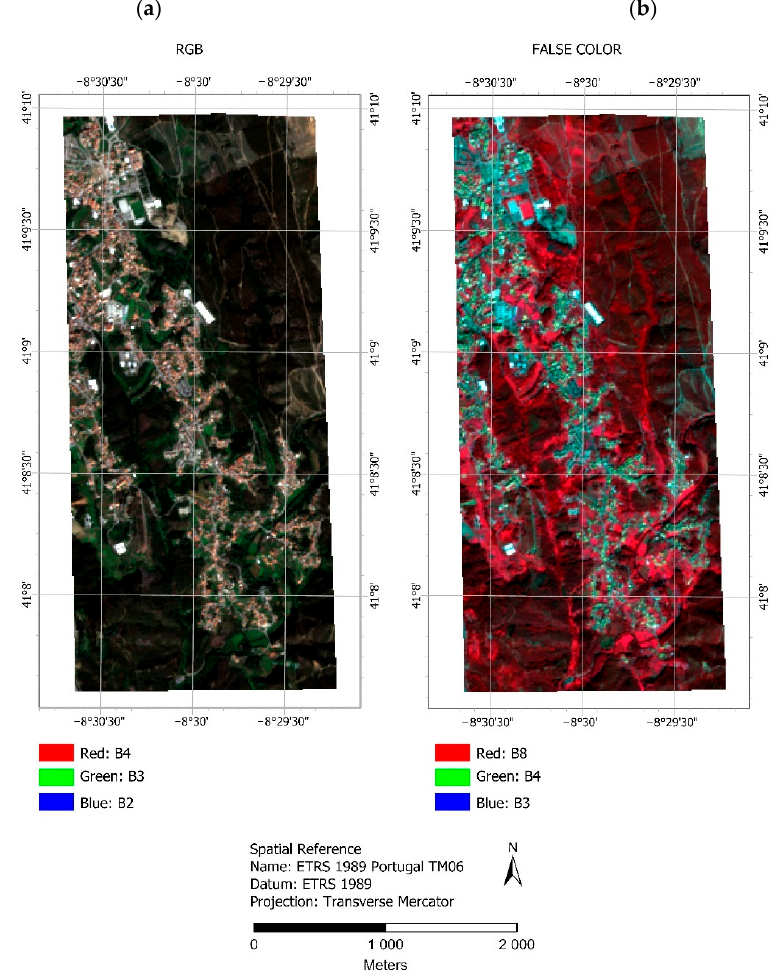
Figure 3. ( a ) RGB composition and ( b ) False color map.